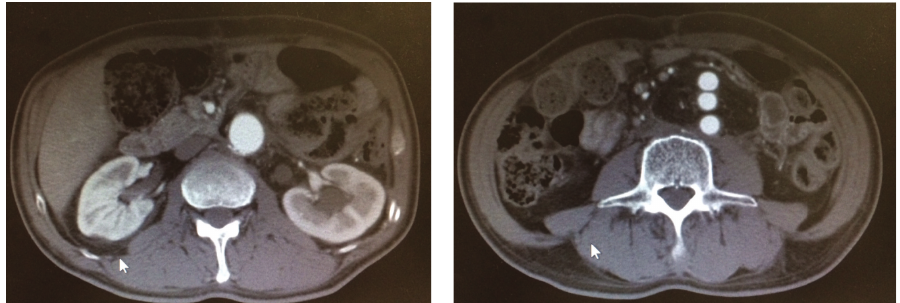
Figure 2: Computed tomography scans taken when the patient was discharged. No leakage of blood into the area around the artificial vascular graft or residual abscess was seen. The omentum with intact blood flow can be seen in the area around the graft.